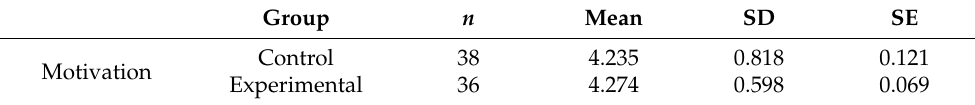
Table 3. Students’ motivation from questions (items A7–A13, Table 1).